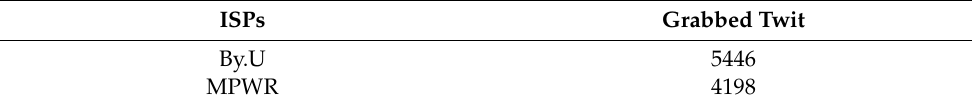
Table 3. Statistics of the collected dataset.